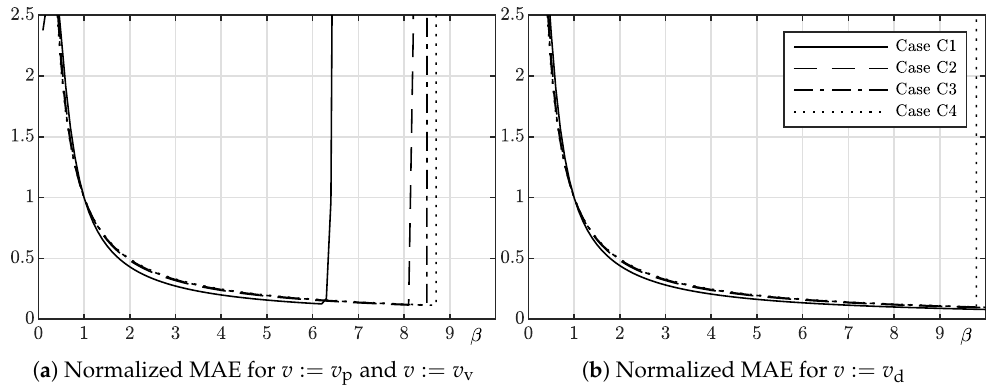
Figure 5. Values of normalized MAE criterion in the simulation of scenario